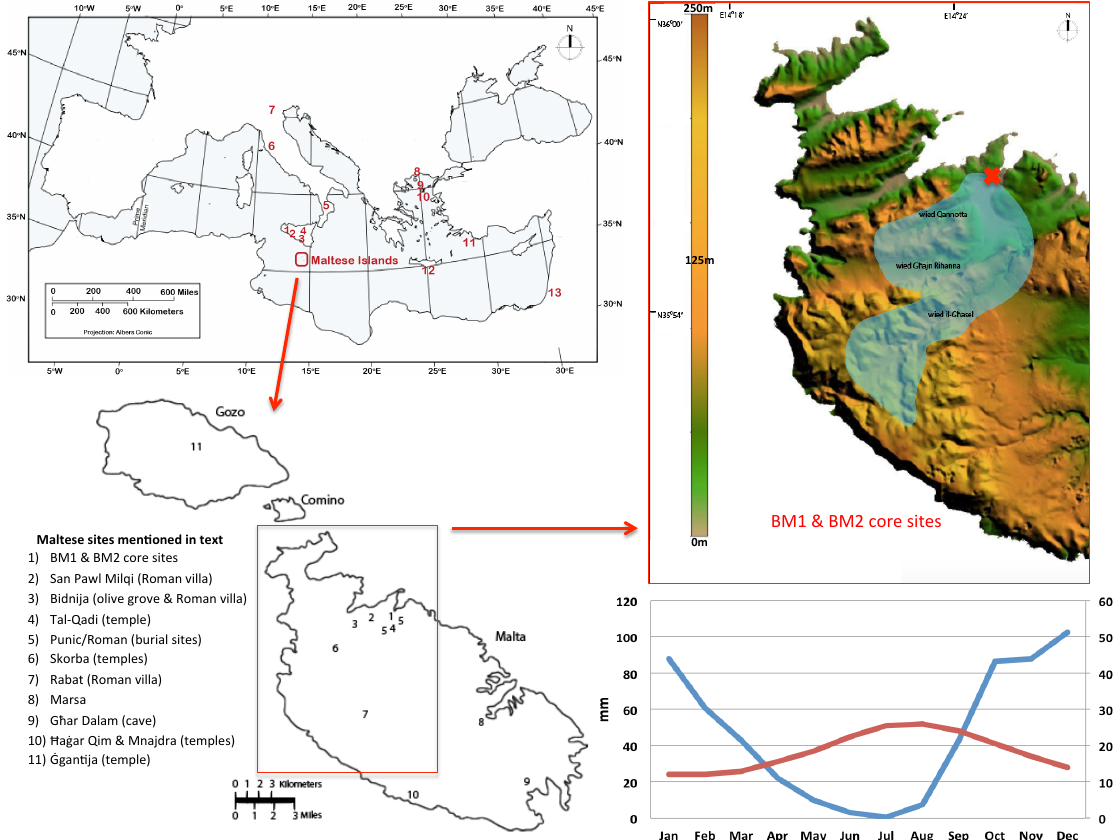
Figure 1. Study area. (a) Mediterranean region highlighting the Maltese Islands. Selected regional sites mentioned in text: 1: Lago Preola, 2: Gorgo Basso, 3: Biviere di Gela, 4: Lago Pergusa, 5: Lago Trifoglietti, 6: Lago Accesa, 7: Lago Ledro, 8: Tenaghi P., 9: SL152, 10: MNB-3, 11: NS14, 12: HCM2-22, 13: Soreq Cave; base map source: Arizona Geographic Alliance; (b) Maltese Islands: key sites mentioned in text; (c) average annual temperature and rainfall, based on Galdies (2011) data for the 30-year climatic period 1961–1990; (d) the topography and catchment area (blue) of Burmarrad.